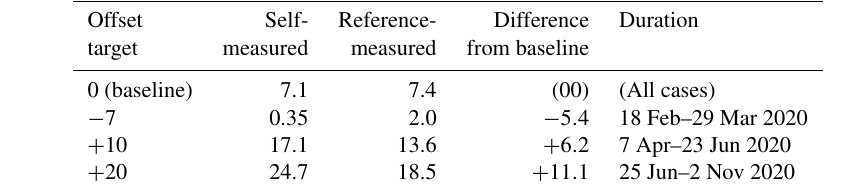
Table 2. Summary of self- and reference-measured mean offsets by target.